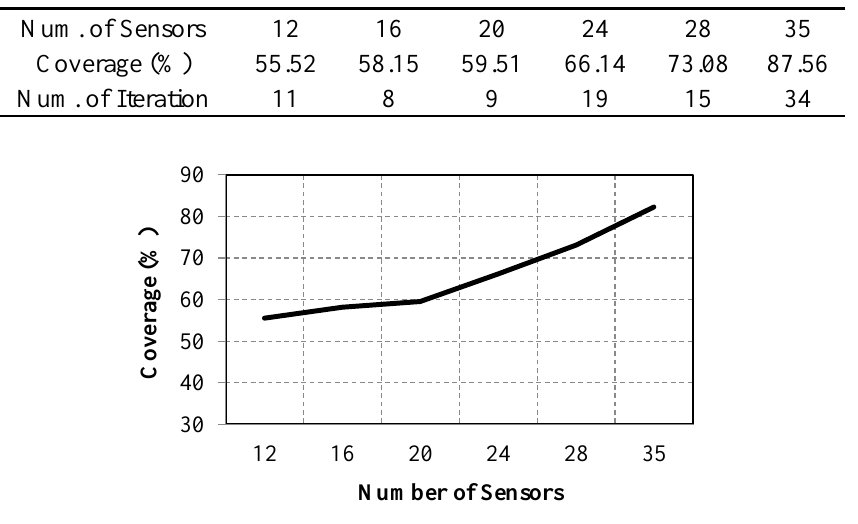
Figure 18. Impact of number of sensors on the coverage obtained by the context-aware method in case of considering the restricted area (Zones 1 and 2).